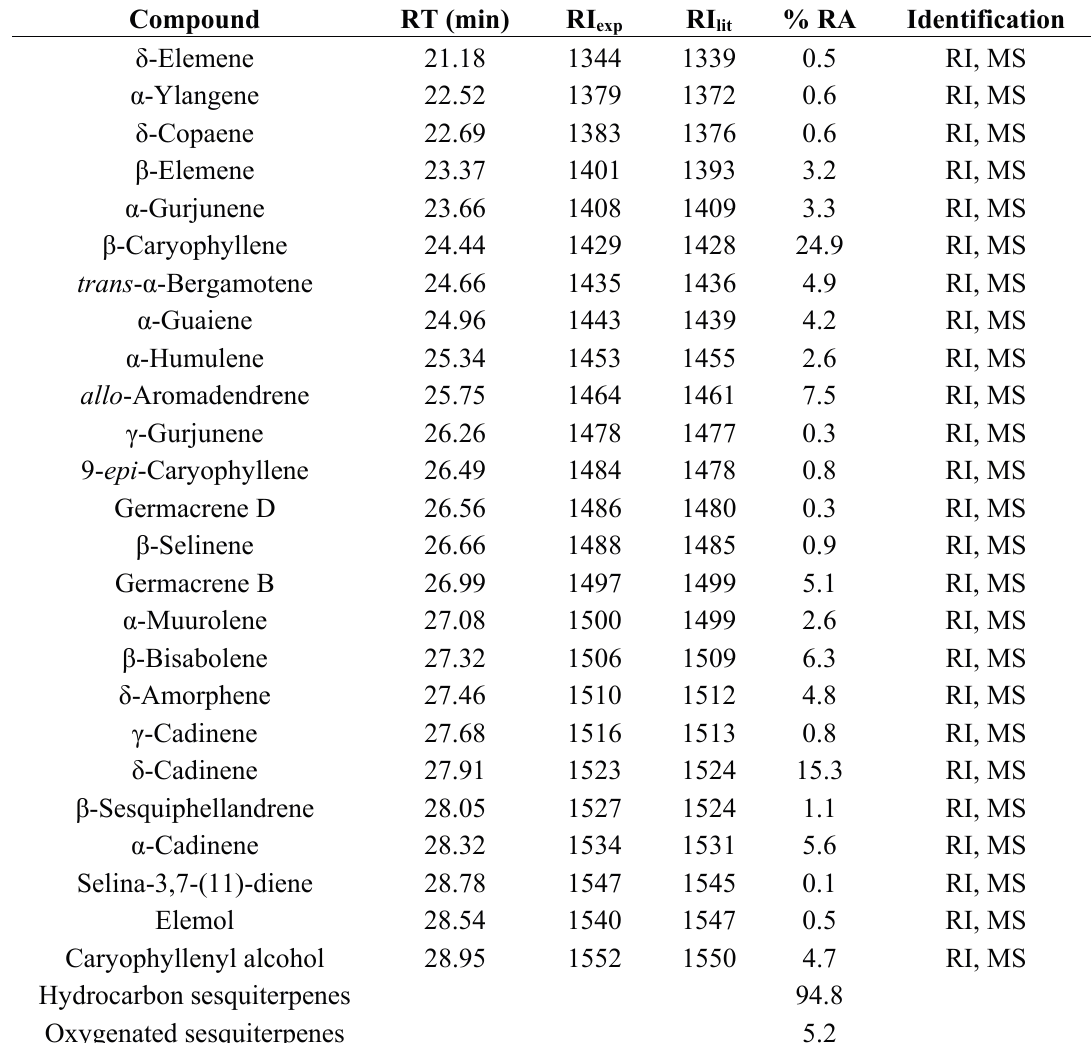
Table 1. Chemical composition of the COP identified by